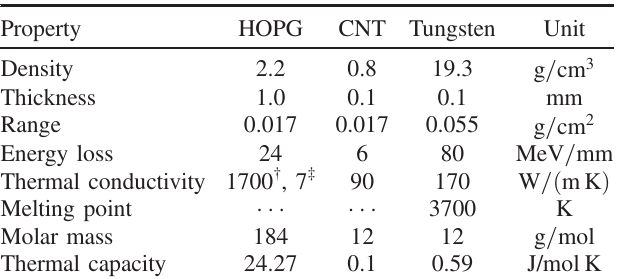
TABLE I. Basic properties of HOPG, CNTs, and tungsten [3,11,12,14,19]. † : in the identical plane, ‡ : face-to-face. Property HOPG CNT Tungsten